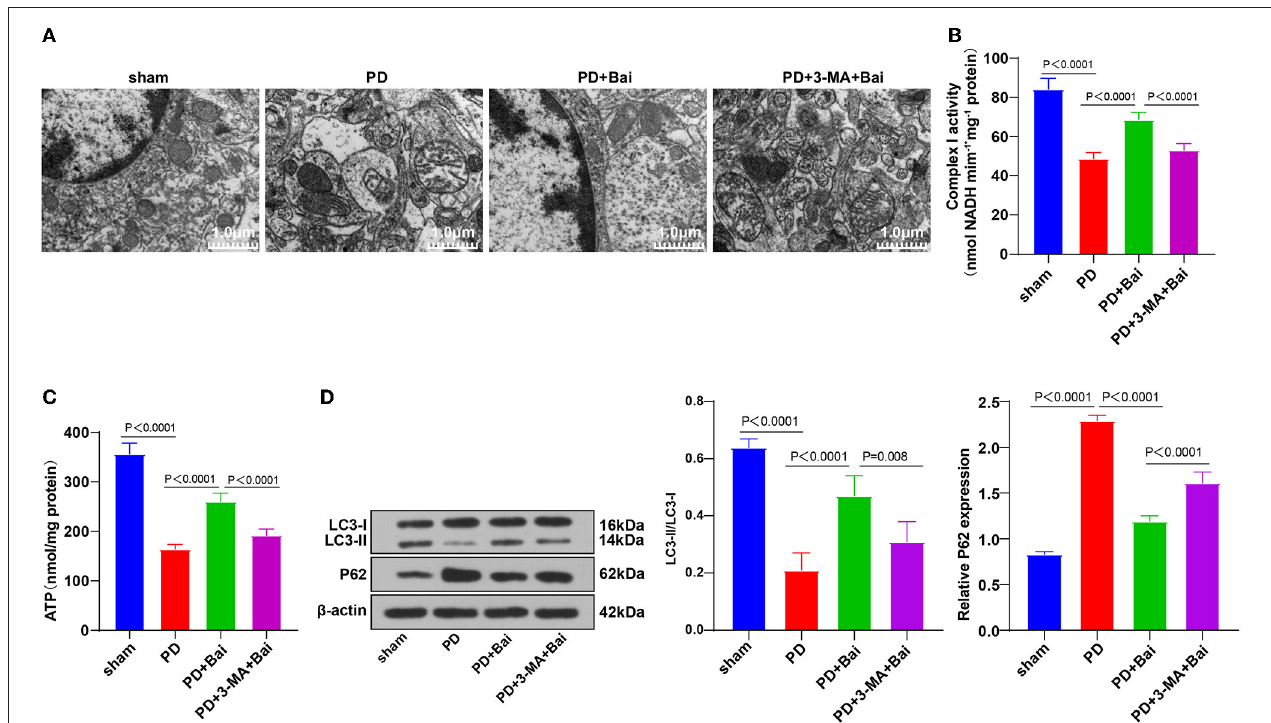
FIGURE 1 | Baicalein played a protective role by promoting mitochondrial autophagy. PD rats were jointly intervened by baicalein and autophagy inhibitor 3-MA. (A) The ultrastructure of mitochondria was observed using TEM; (B,C) the activities of mitochondrial complex I and ATP were detected using kits; (D) the levels of autophagy marker proteins LC3-II/I and p62 were detected by WB. N = 6. The data in the figure are all measurement data and expressed as mean ± standard deviation; one-way ANOVA was used for variance analysis; Tukey’s multiple comparisons test was used for the post hoc